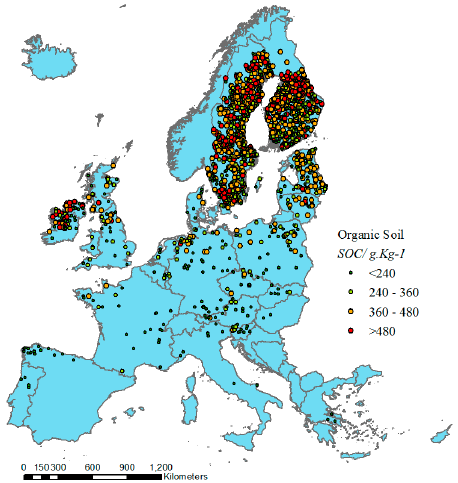
Figure 1. Distribution of organic soil samples in the Land Use/Land Cover Area Frame Survey (LUCAS) topsoil database. Colours indicate amounts of soil organic carbon (SOC) content.